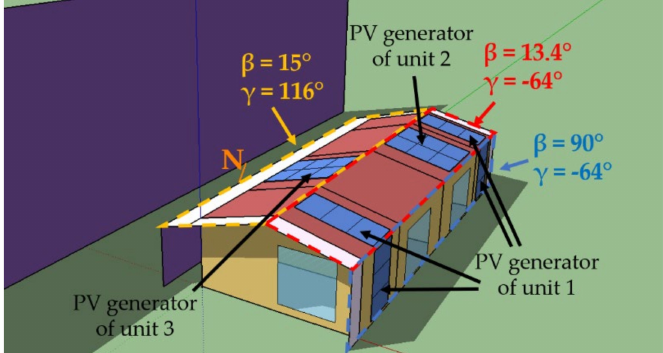
Figure 4. Disposition and allocation of PV arrays among the three